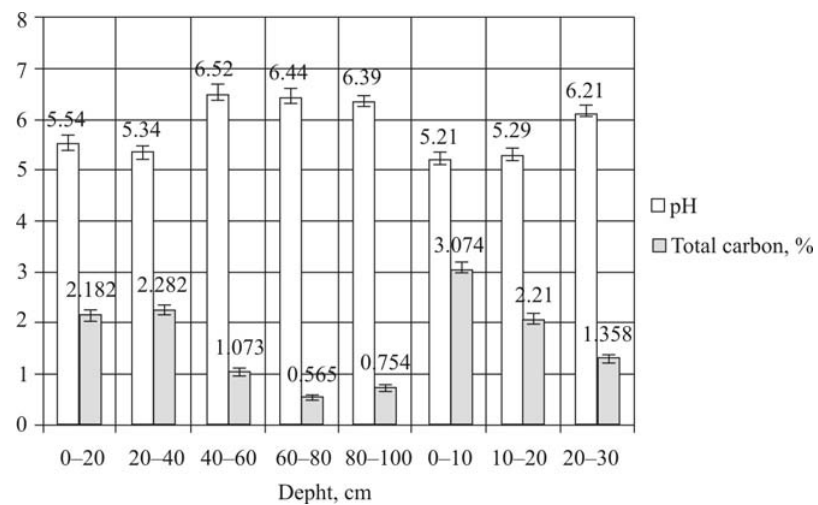
Fig. 3. Soil pH and total carbon content in the second meadow plot